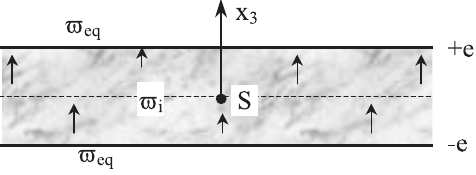
Fig. 8. Initial and boundary